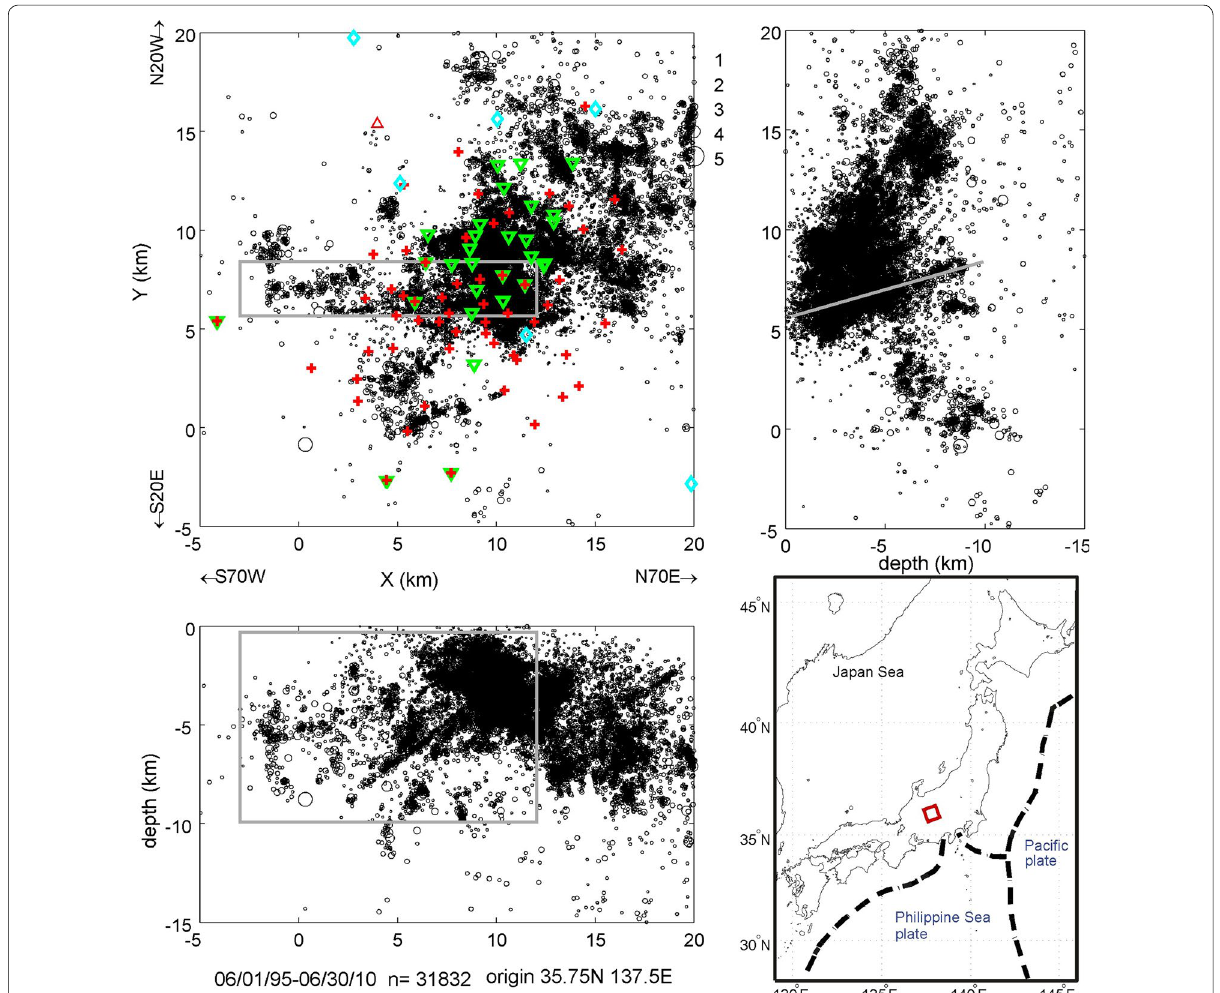
Fig. 2 Locations of hypocenters of events analyzed in this paper, the earthquake fault (blue rectangle) estimated by Yoshida and Koketsu (1990), and seismic stations. Locations of seismic stations of the high-sampling and Manten observation networks and permanent stations (operated by NIED, JMA, and Nagoya University) are indicated by red crosses, green reversed triangles, and cyan diamonds, respectively. Black circles are earth- quakes used in this study, which occurred from June 1995 to June 2010. Red rectangle in the large-scale map indicates the study